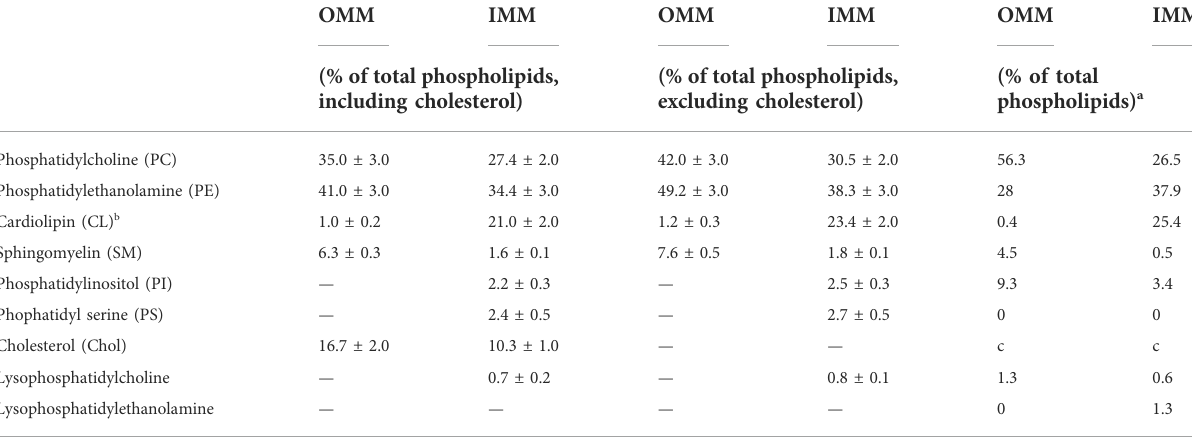
separation (See Table 1 for a comparative lipid composition between IMM and OMM).